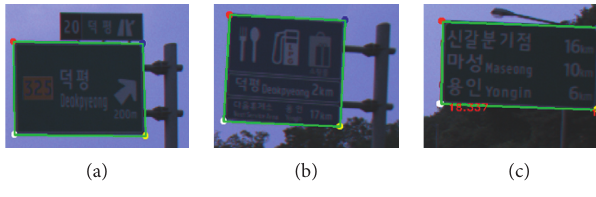
Figure 7: Examples of an additional road facility. Table 1: Sensor specifications of the MMS.